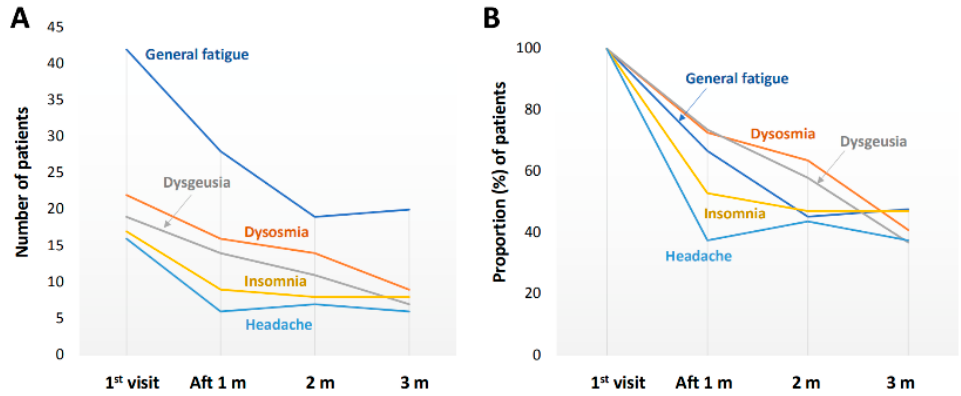
Figure 2. Improvements in the five most common symptoms of long COVID in the three-month follow-up period. Changes in ( A ) the number of patients and ( B ) the proportion (%) of patients who suffered from each symptom.